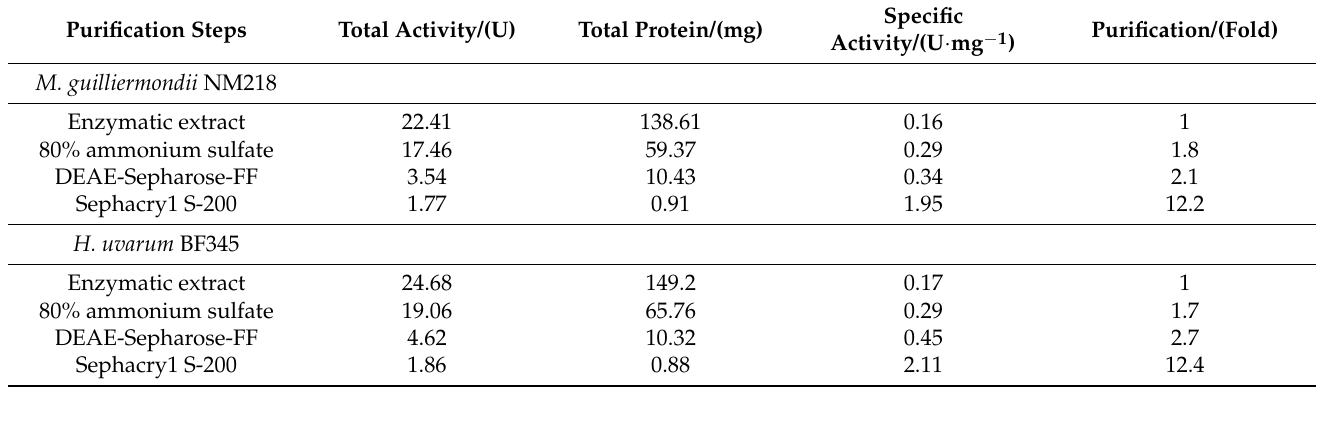
Table 1. Purification protocol for the β -glucosidase from M. guilliermondii NM218 and H. uvarum BF345.